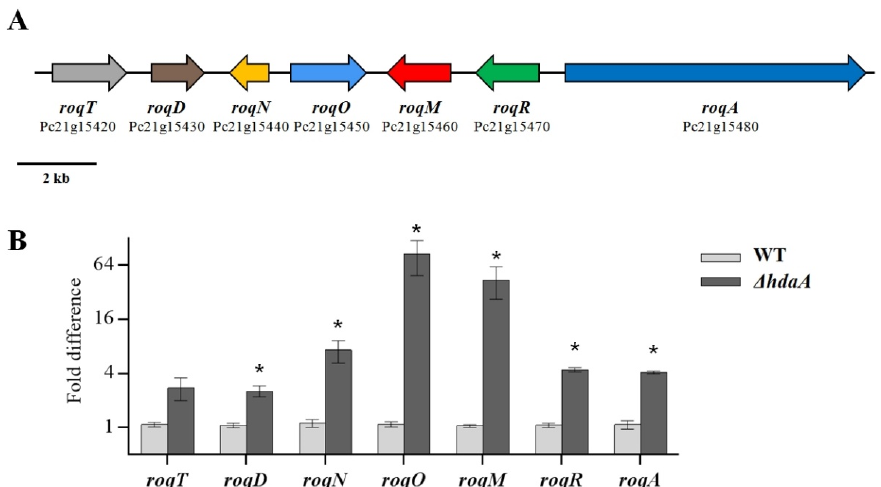
Figure 5. Transcriptional analysis of the meleagrin/roquefortine biosynthetic gene cluster. ( A ) Organization of the meleagrin/roquefortine BGC. ( B ) Quantitative RT-PCR analysis of the meleagrin/roquefortine BGC. The analysis for each strain was performed in triplicate. Data are shown as fold change relative to the first trial of the WT. Mean values with asterisk are significant at p < 0.01.